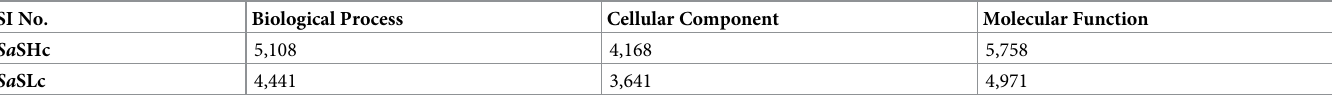
Table 2. Samples wise Gene ontology (GO) category distribution of coding sequences (CDS) in S . album . SI